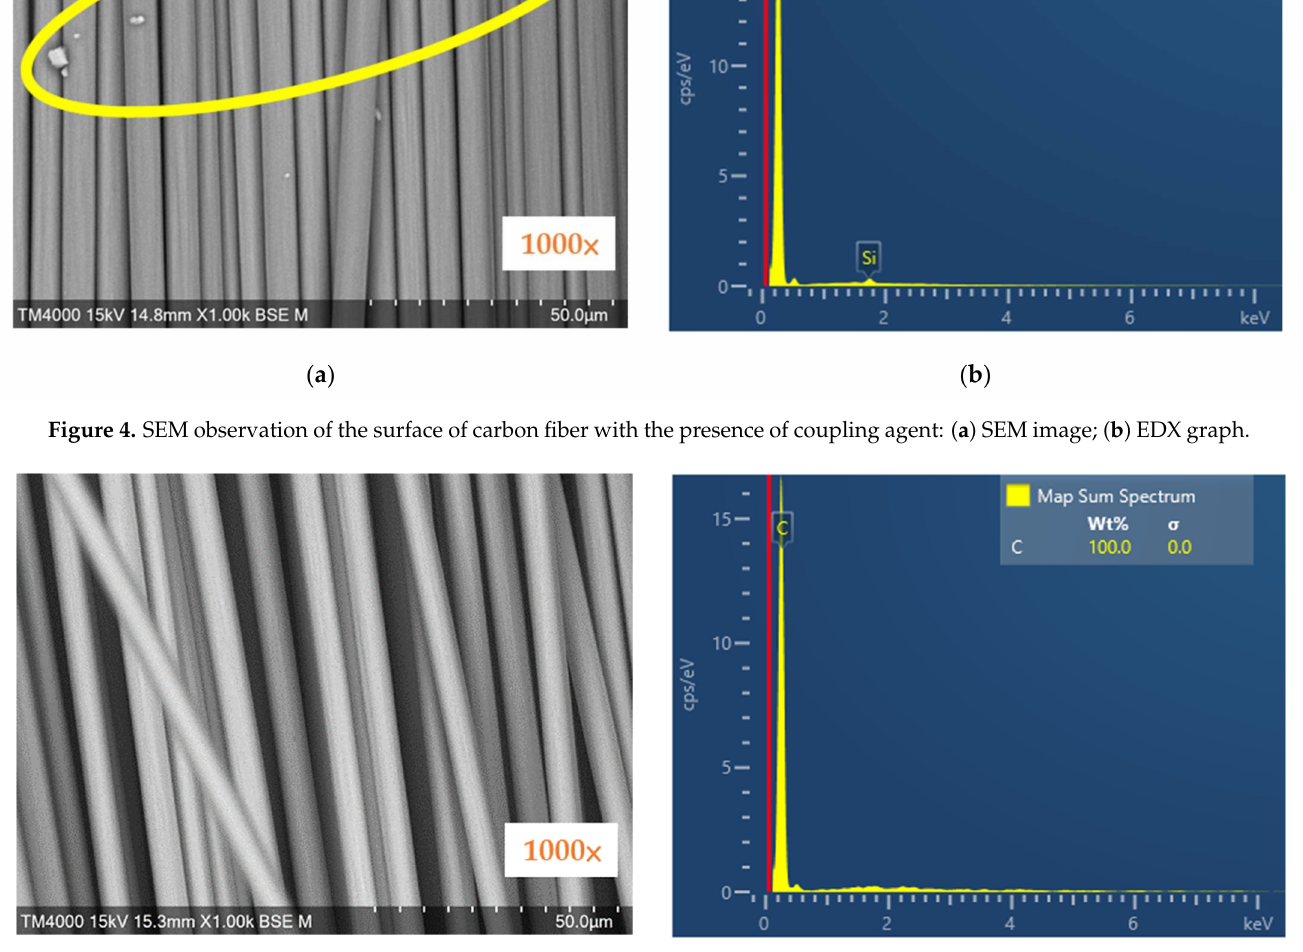
Figure 4. SEM observation of the surface of carbon fiber with the presence of coupling agent: ( a ) 234 SEM image; ( b ) EDX graph. 235